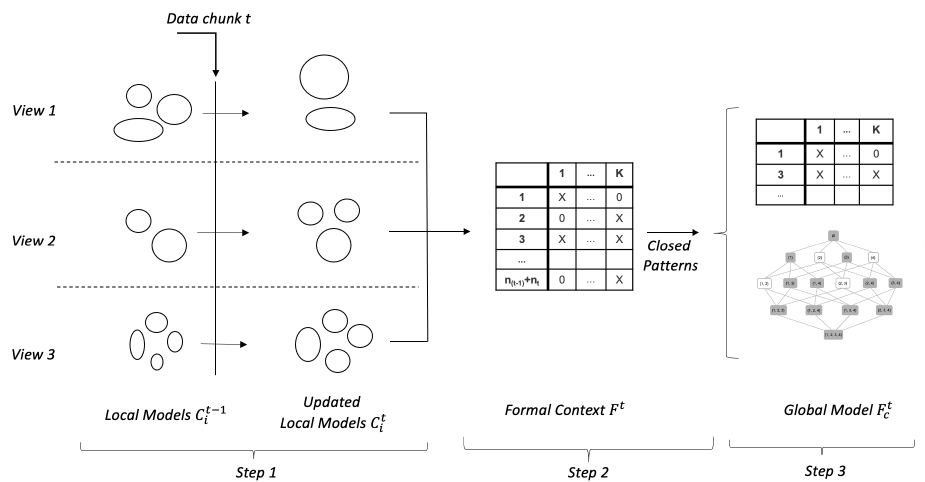
Figure 1. A schematic illustration of different steps of the MV-MIC